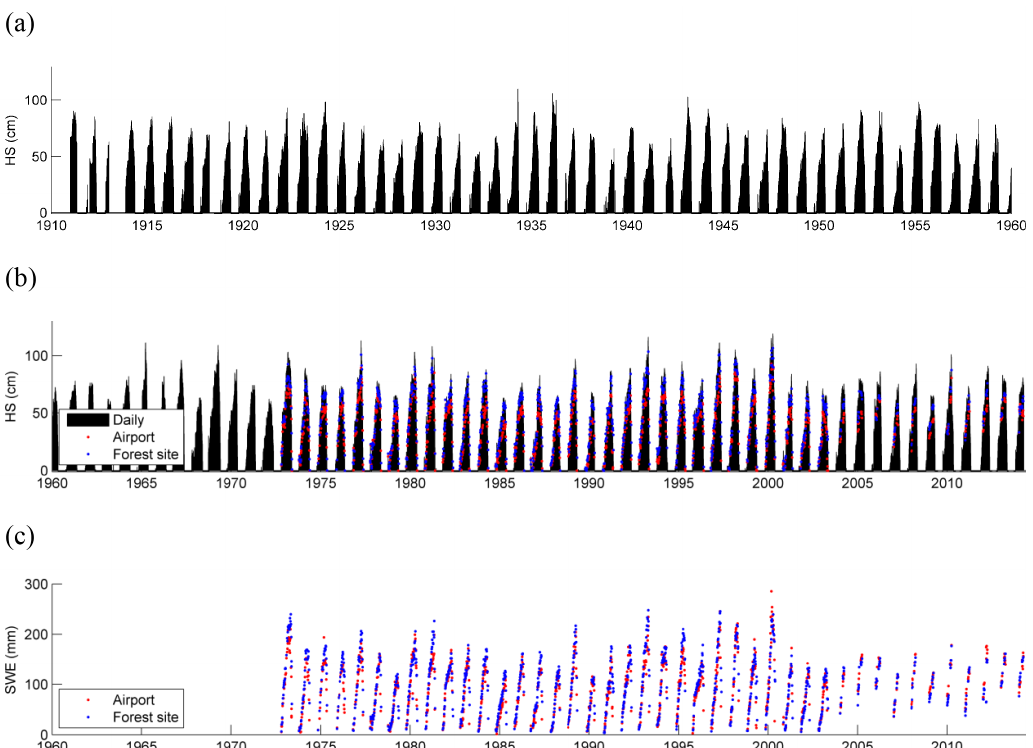
Figure 7. Time series in (a) and (b) HS measurements in 1911–2015, and (c) SWE measurements every 5 days (only in January and March from 2002) in